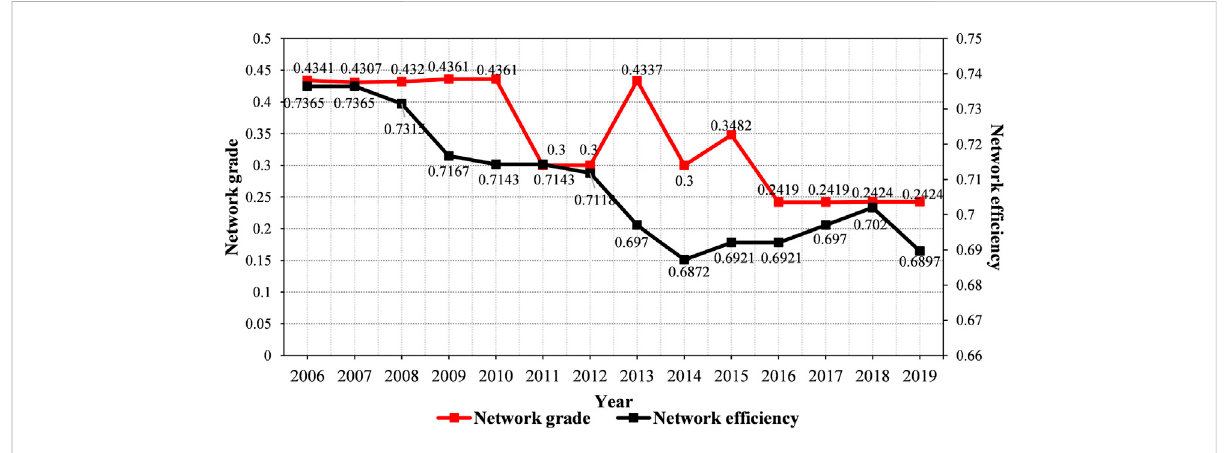
FIGURE 5 The network grade and ef fi ciency of the transportation GTFP